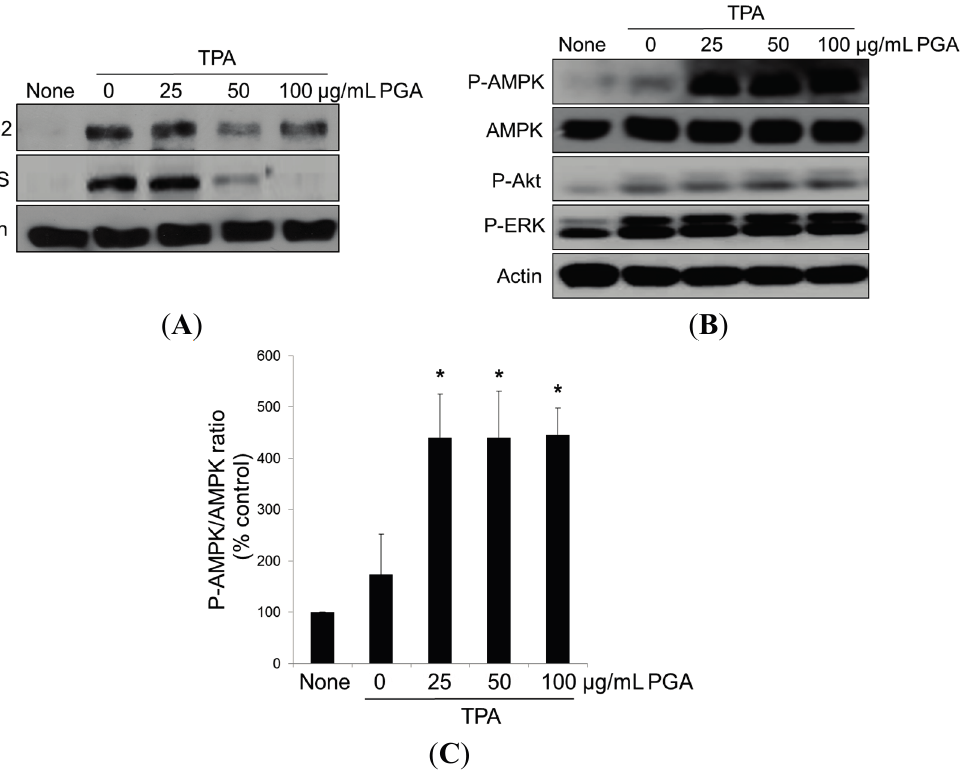
Figure 3. Effect of PGA on COX-2, iNOS, and AMPK in TPA-induced HT-29 cells. Cells were treated with 100 nM 12- O -tetradecanoylphorbol-13-acetate (TPA), alone or in combination with PGA, at 25, 50, 100 μ g/mL for 24 h, and then COX-2 and iNOS expressions were determined under a Western blot analysis ( A ); Cells were treated with 12- O -tetradecanoylphorbol-13- acetate (TPA), and different concentrations of PGA at 25, 50, 100 μ g/mL for 1 h, and then AMPK, Akt, and ERK phosphorylations were determined by Western blot analysis with specific antibodies ( B ); and each bar represents the P-AMPK/AMPK protein ratio ( C ). * p < 0.05 vs. TPA